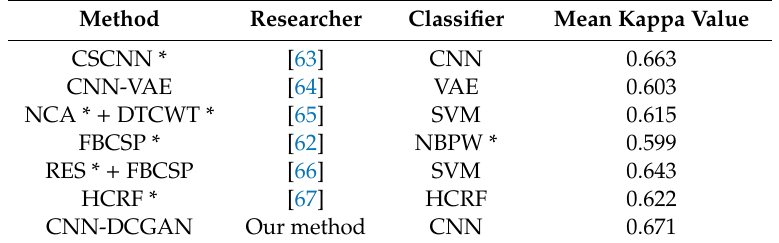
Table 11. The classification performance of di ff erent methods for the BCI competition IV dataset